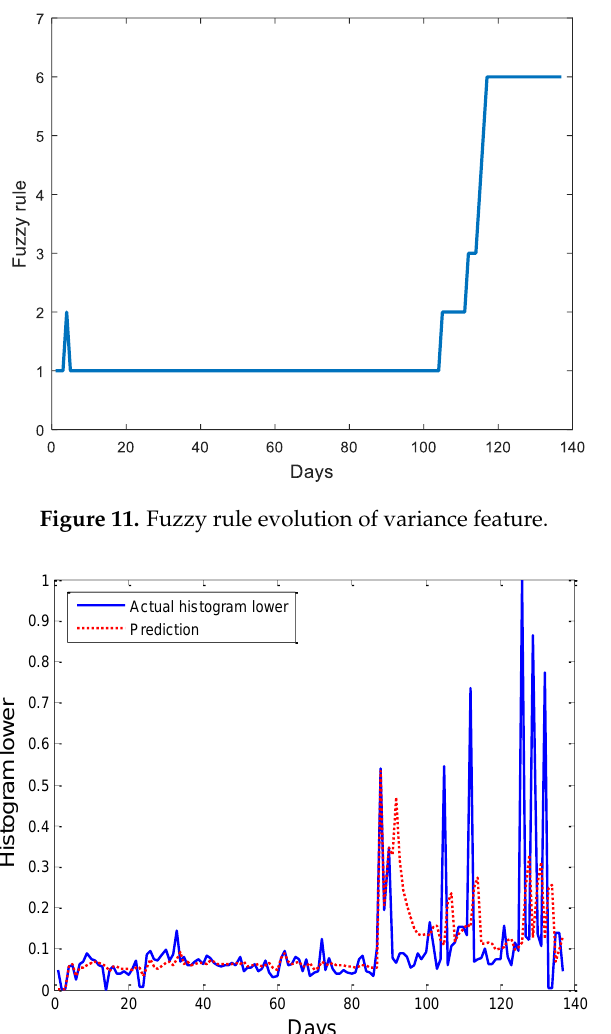
Figure 10. PANFIS prediction of variance feature.